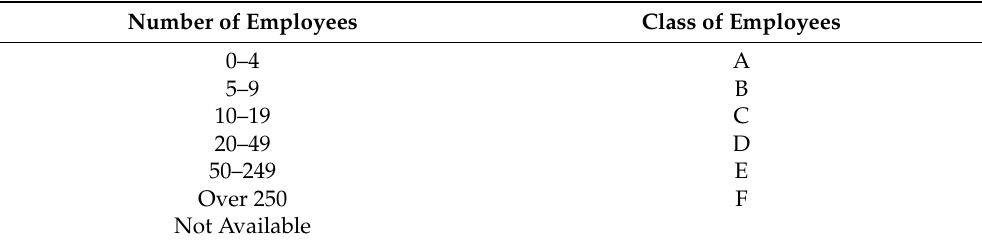
Table A3. Shows the class of Italian startups’ number of